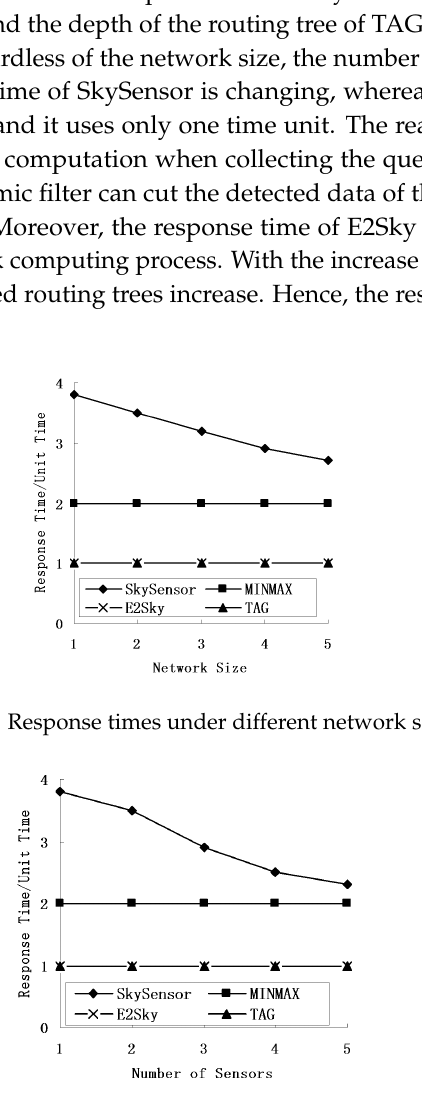
Figure 9. Real skyline percentage under different data dimensionality.